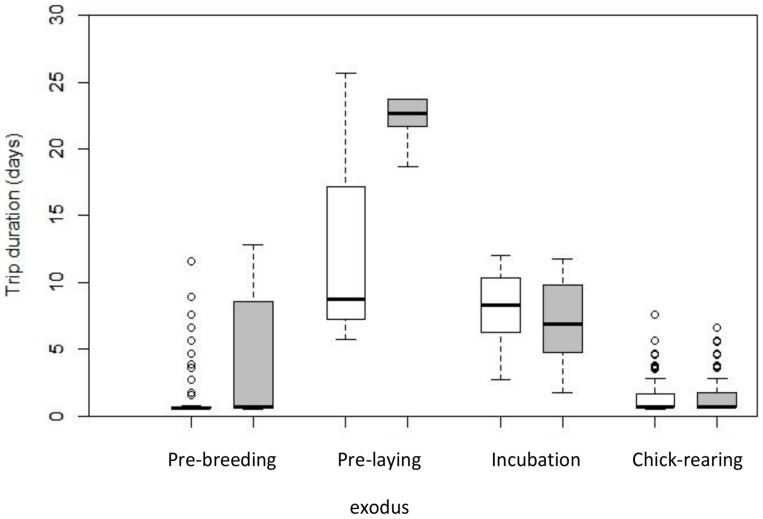
Foraging trip durations of Sooty Shearwaters during the pre-breeding and breeding periods.Males are depicted in white and females in grey. Box plots show the median and 25th and 75th percentiles, whiskers indicate values within 1.5 times the interquartile range and circles represent outliers.